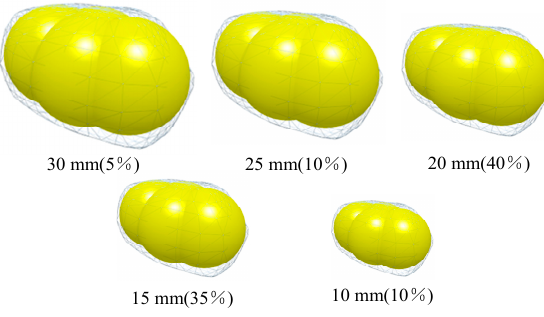
Figure 6. Particle size distribution.